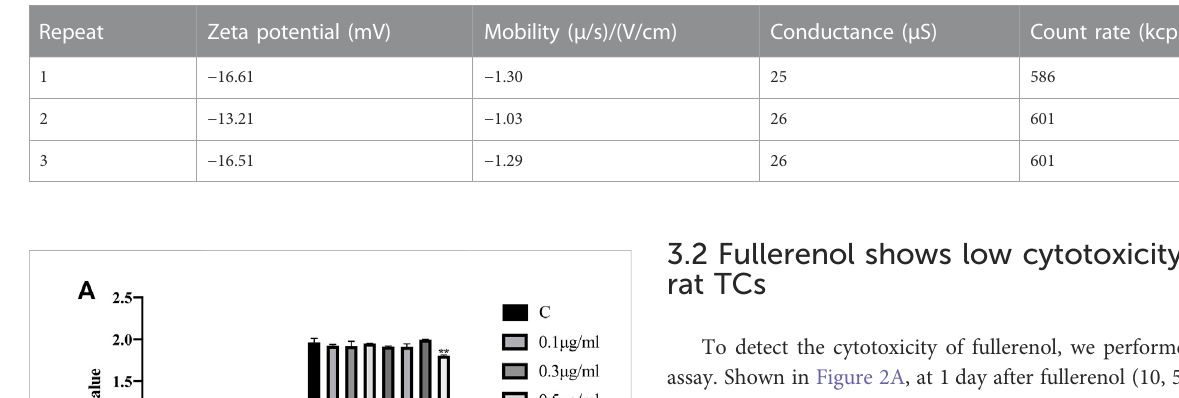
TABLE 2 Zeta potential of aqueous fullerenol.